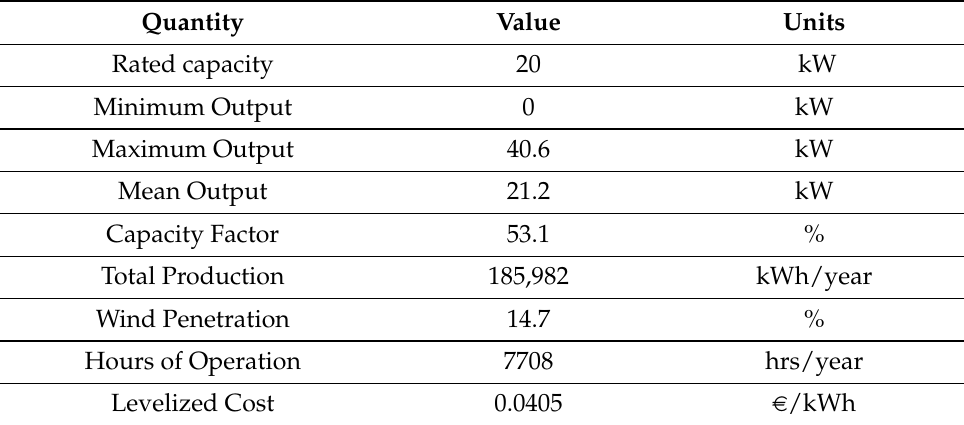
Table 11. Wind Turbines Scheme Simulation